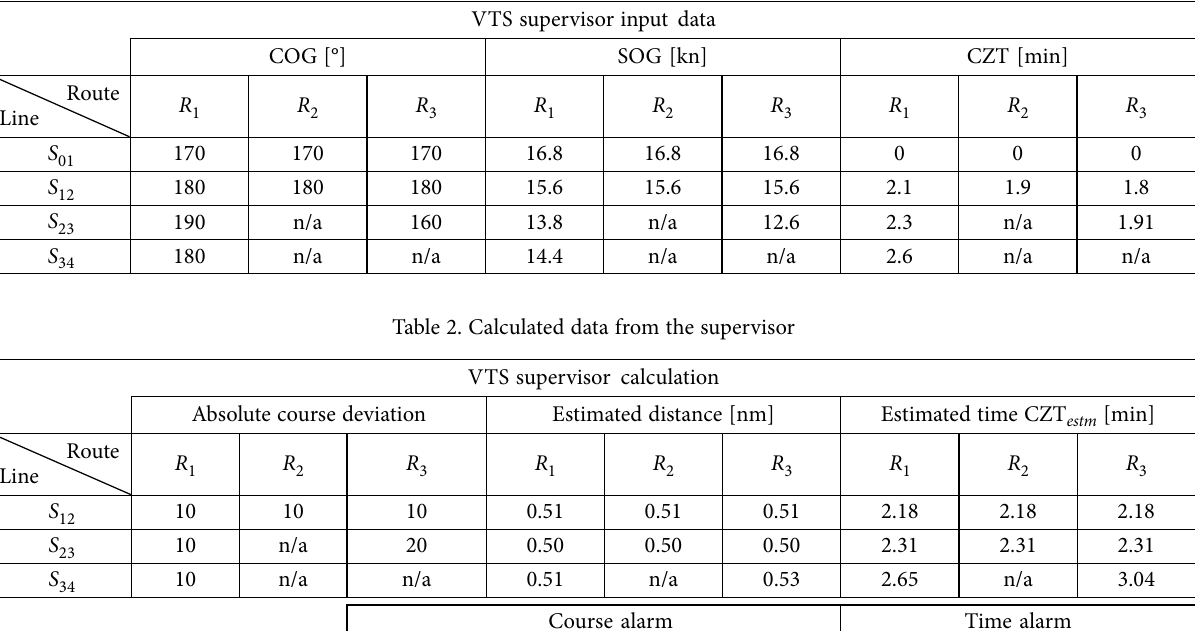
Table 1. Data from VTS supervisor